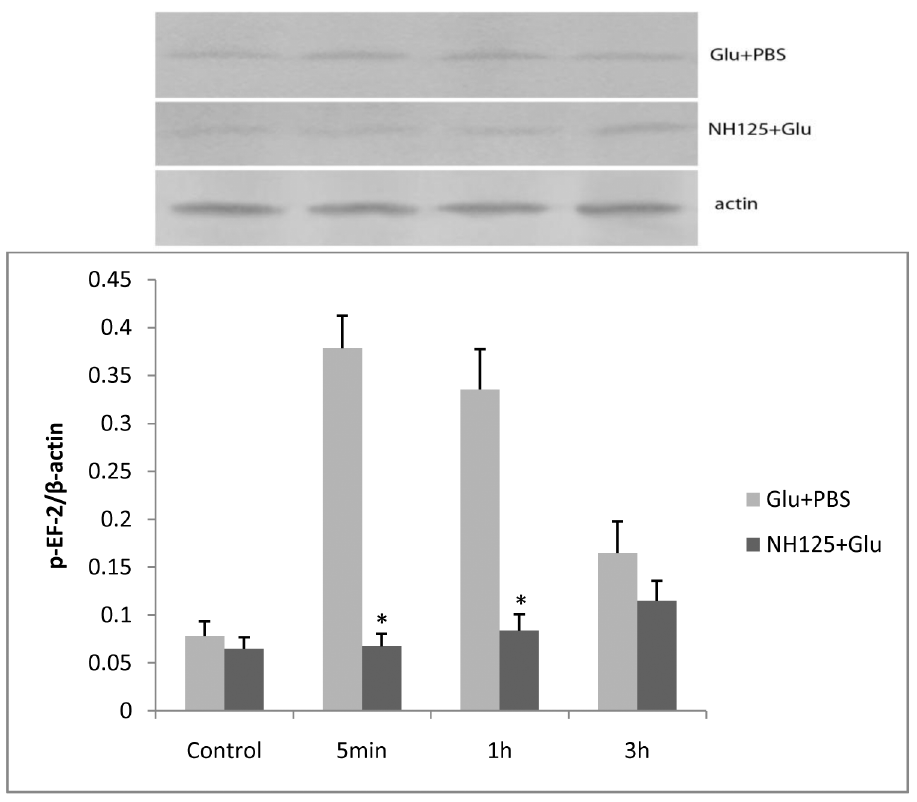
Fig 10. After adding NH125, expression of phospho-eEF-2 was lower in the NH125 + Glu group than in the Glu + PBS group at 5 min and 1 h. The asterisk represents P < 0.05.